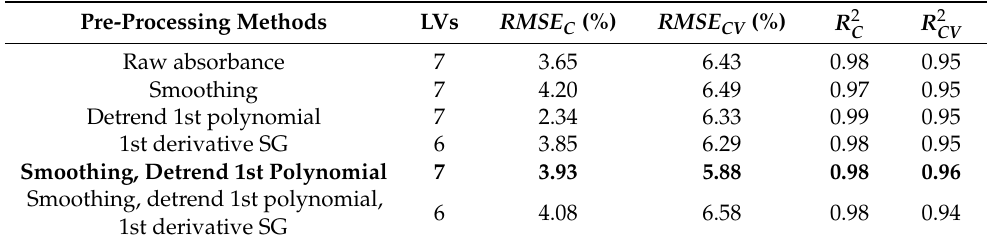
Table 1. Calibration and cross-validation results of the PLSR model performed on pre-processed spectral data at the range 400–1100